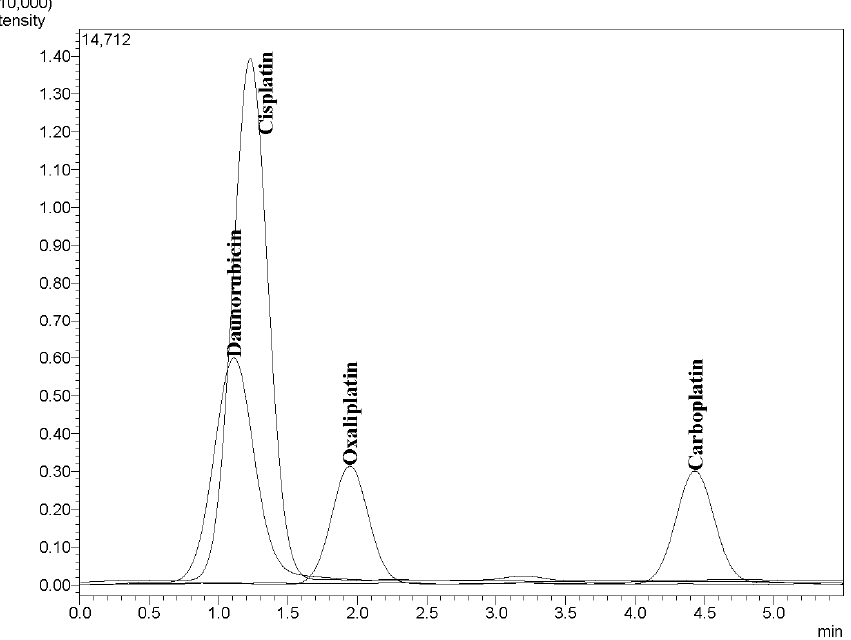
Figure 1. Platinum-based AD Figure 1. Platinum ‐ based AD chromatogram .